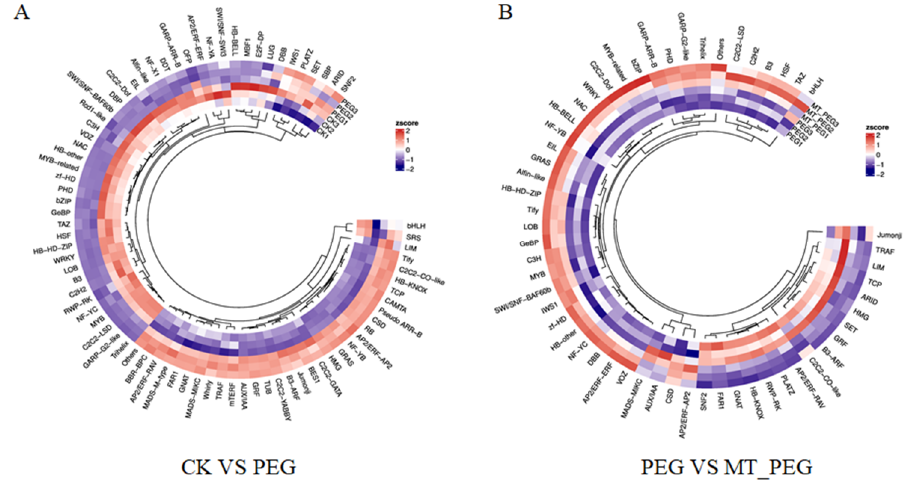
Figure 7. Heatmap of transcription factor families(CK vs. PEG and PEG vs. MT_PEG). ( A ) Transcription factor analysis in the CK vs. PEG comparison group. ( B ) Transcription factor analysis in the PEG vs. MT_PEG comparison group.